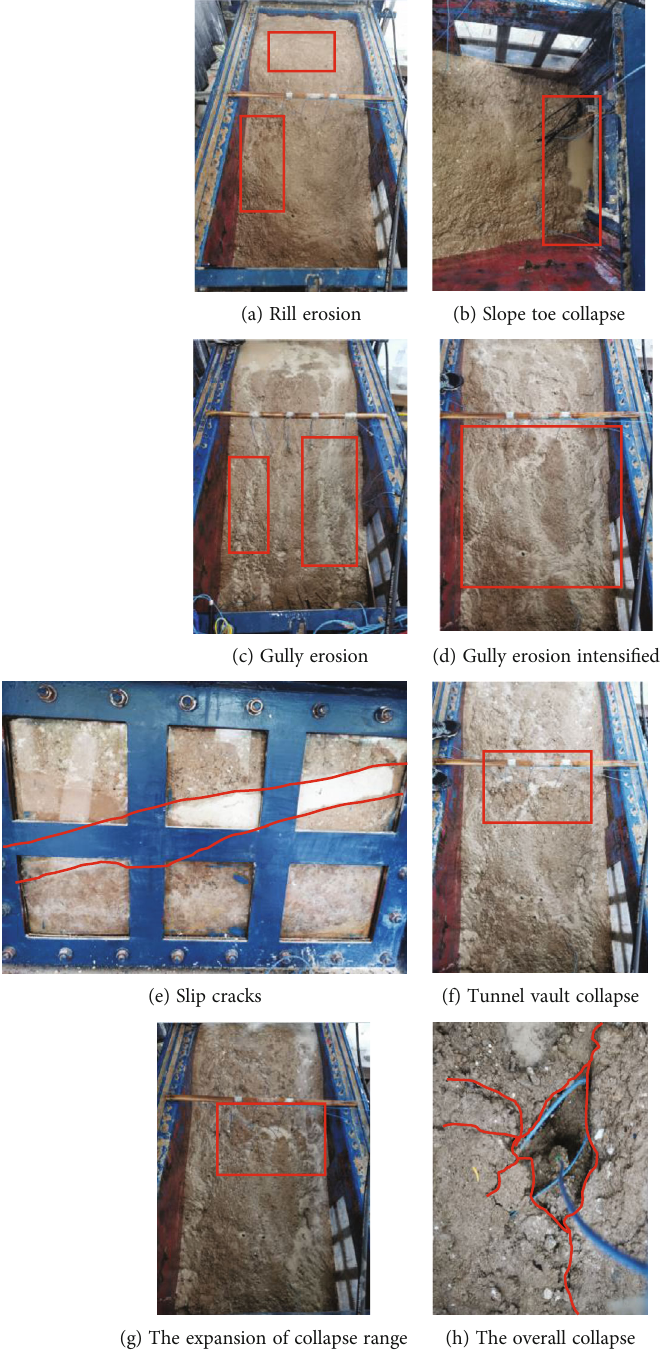
Figure 14: The analysis of the slope instability during